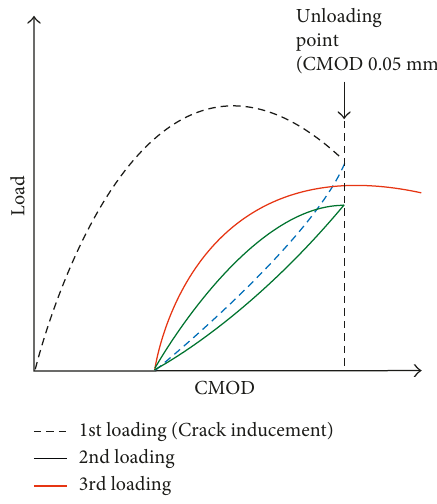
Figure 3: Typical load-CMOD